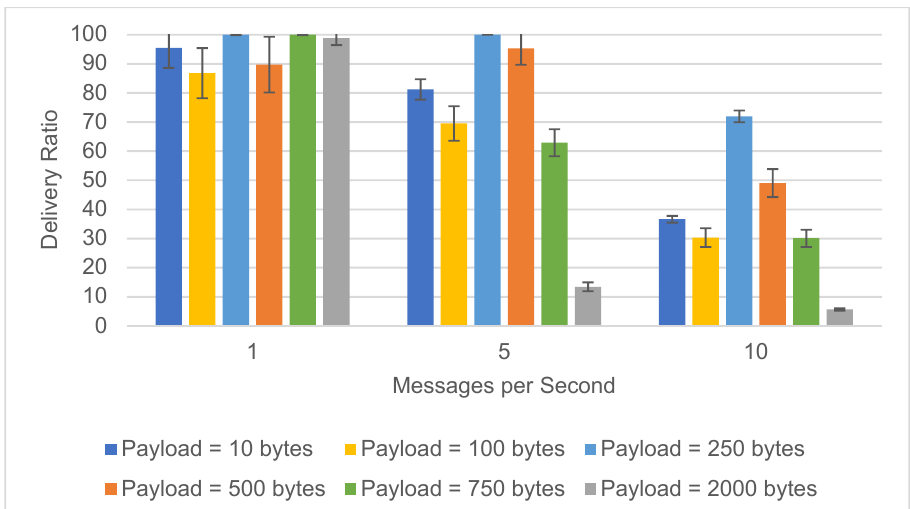
Figure 10. Delivery ratio (%) of messages (1 sensor and 1 destination, MSS = 536 bytes).